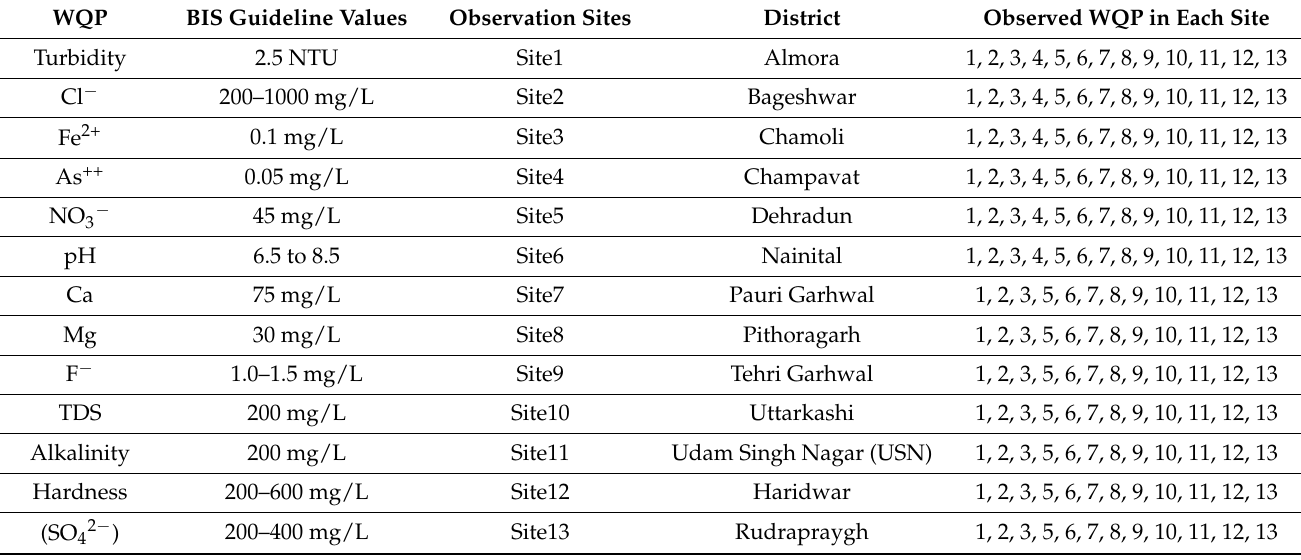
Figure 3. Box plots of the ground water quality parameters in various sites (1–13). Table 1. Observed water quality parameters with their symbols and site wise distribution of the observed water quality parameters